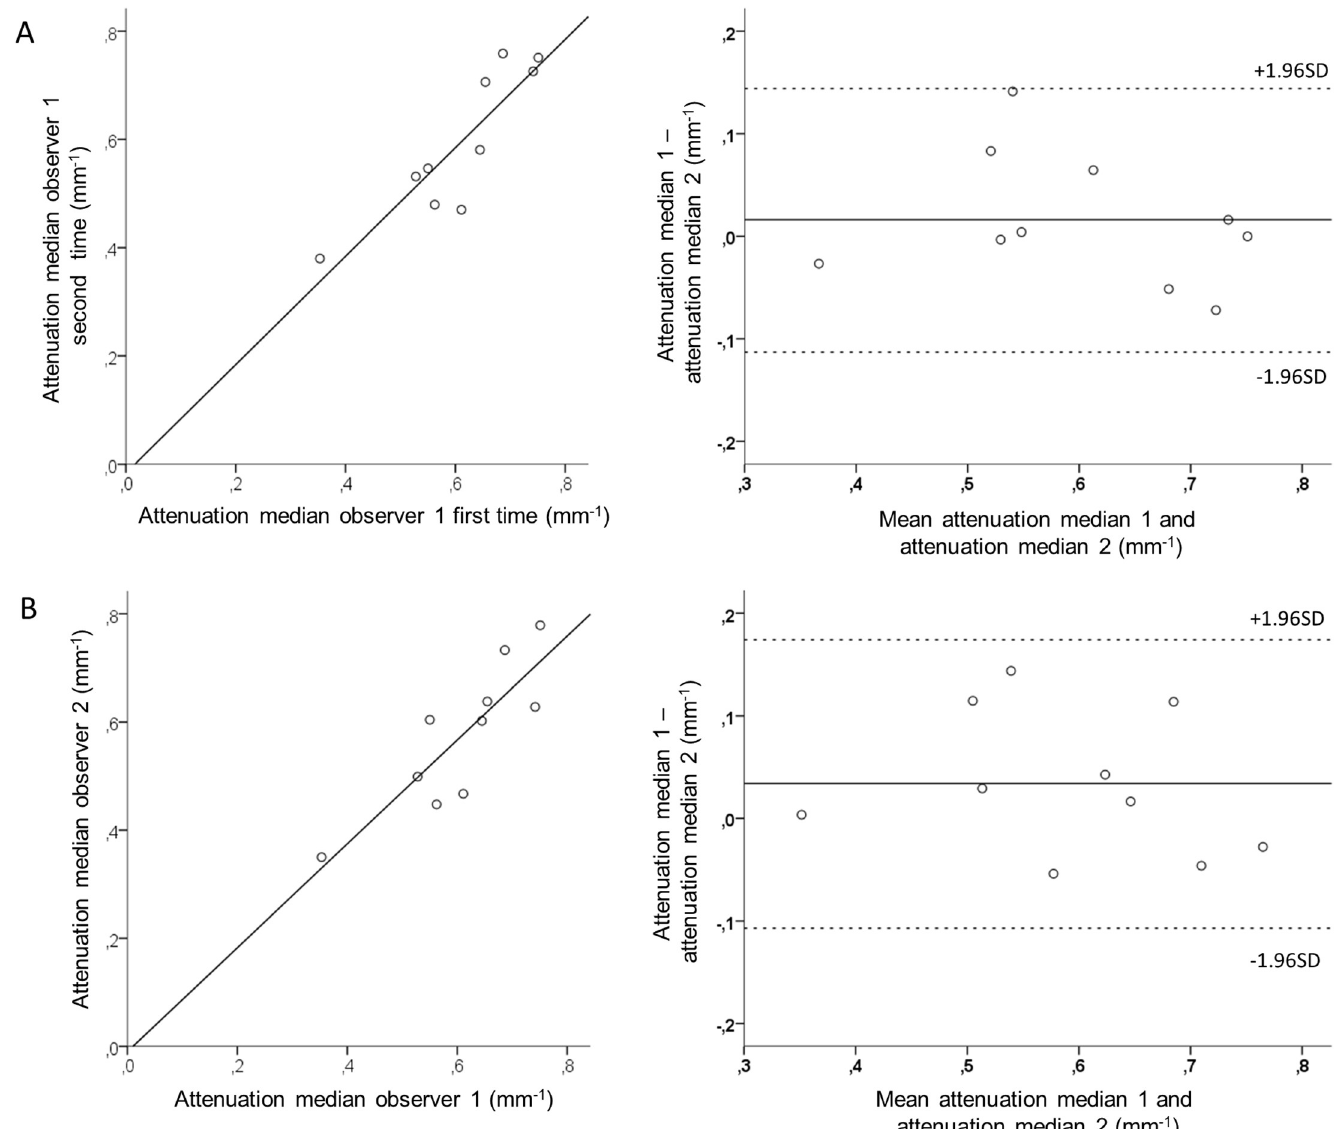
Fig 2. Intra- and interobserver variability of measurement of thrombus attenuation in OCT images using image analysis software. Scatterplot (left) and Bland- Altman plot (right) of intraobserver (A) and interobserver (B) comparison for median attenuation. OCT, optical coherence tomography; SD, standard deviation.